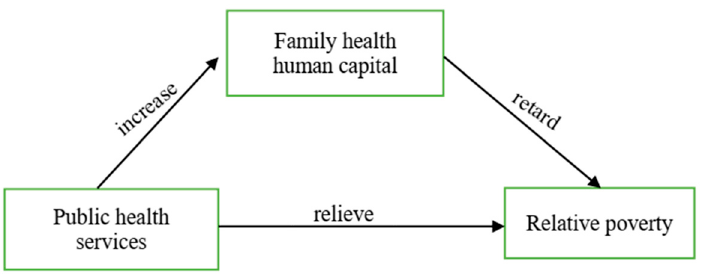
Figure 1. Analysis framework of poverty reduction by public health services.